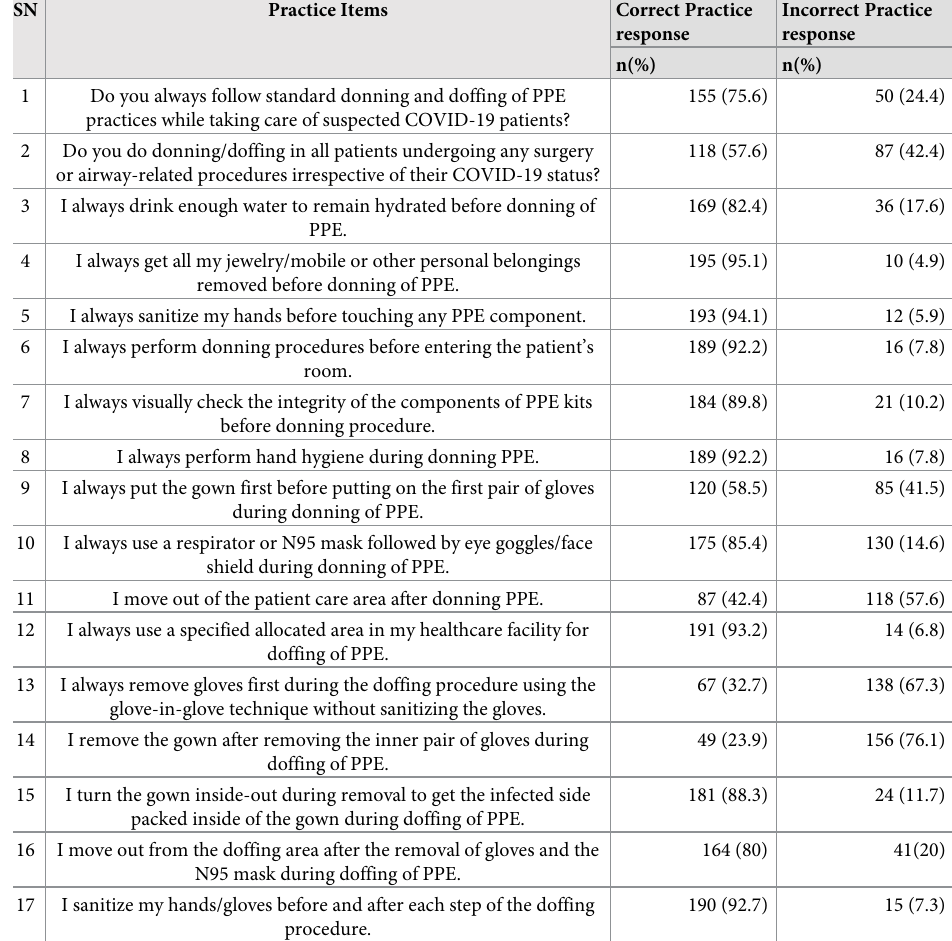
Table 7. Practice score by components among the participants (n =